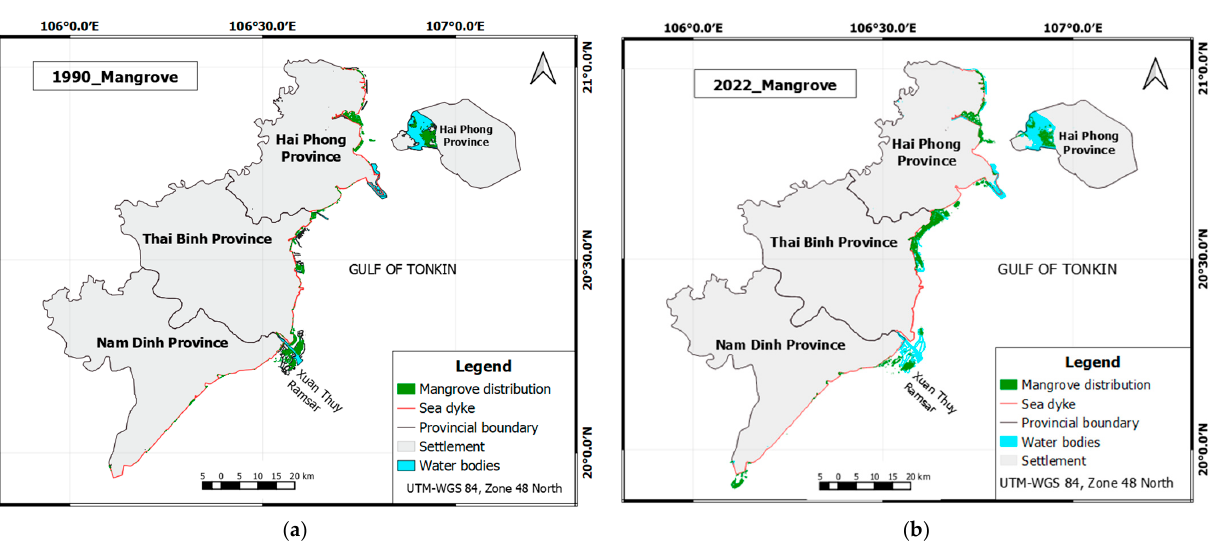
Figure 5. The spatial distribution map of mangrove in the RRD of Vietnam: ( a ) mangrove map in 1990; ( b ) mangrove map in 2022.